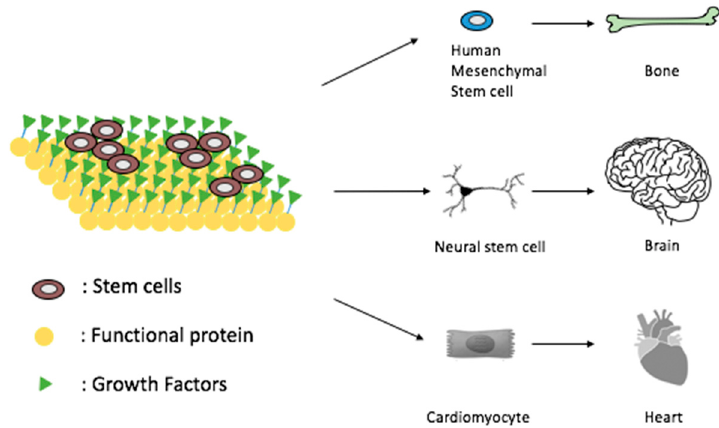
Figure 1. Protein biomimetic materials for tissue regeneration. Table 1. The typical biomaterials used for the various tissue regenerations. Regenerated Tissues and Cells Biomaterials Involved Reference Bone